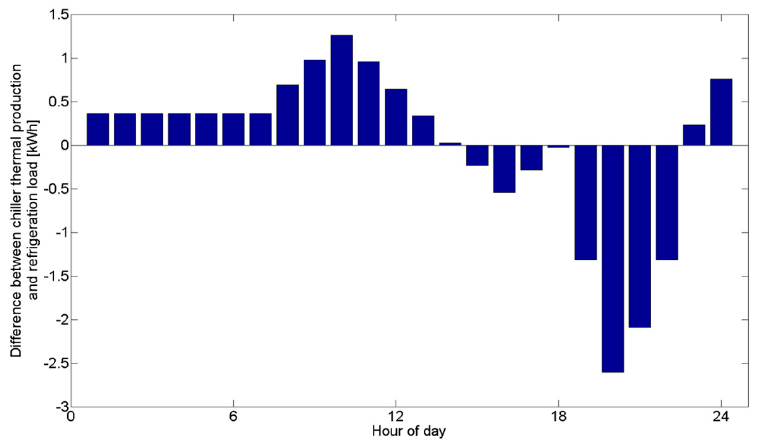
Figure 9. Difference between the chiller thermal production and the refrigeration loads.